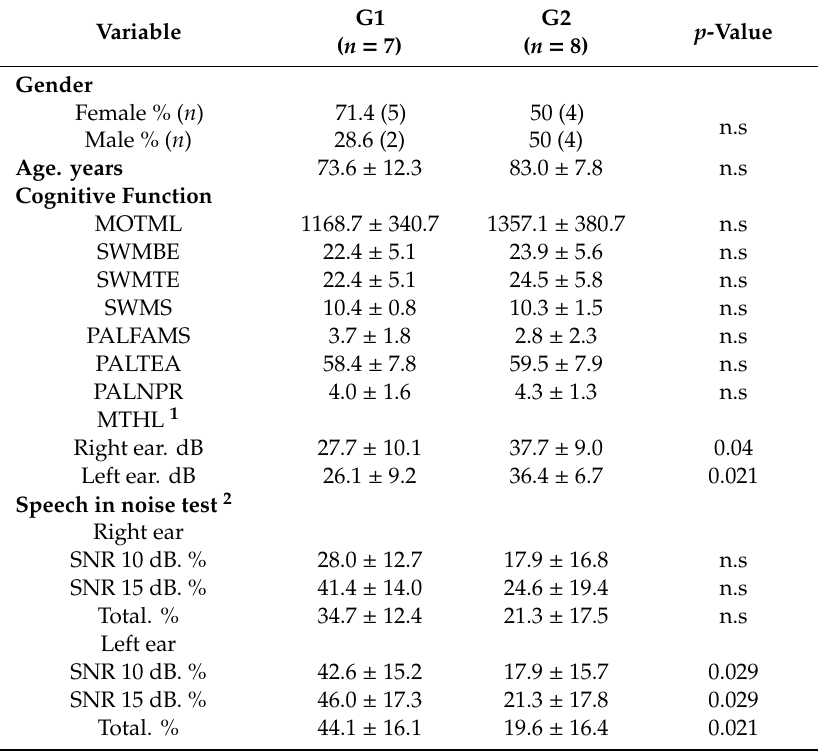
Table 1. Demographic and clinical characterization of the G1 and G2 groups presented in mean ± standard